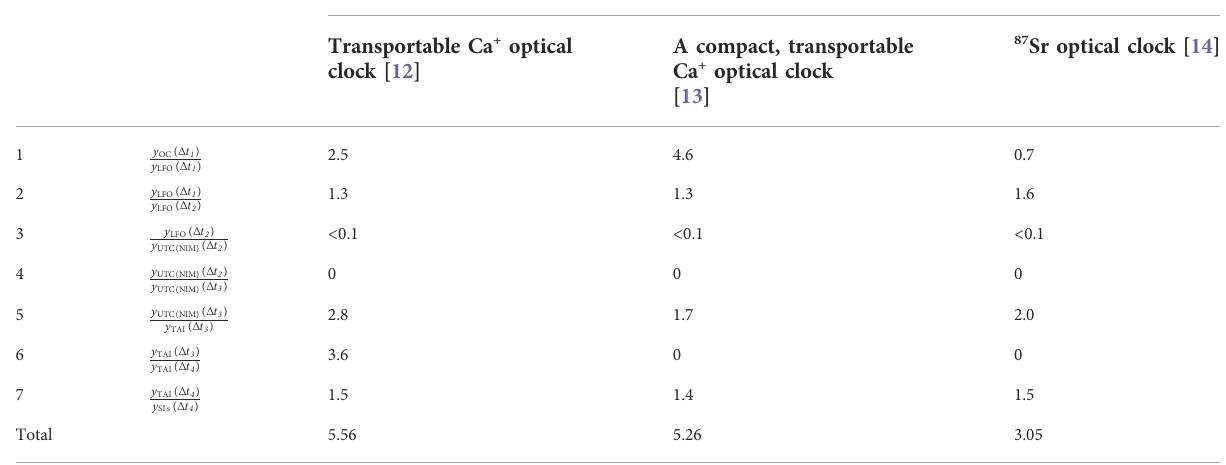
TABLE 1 Uncertainty of optical frequency traceability